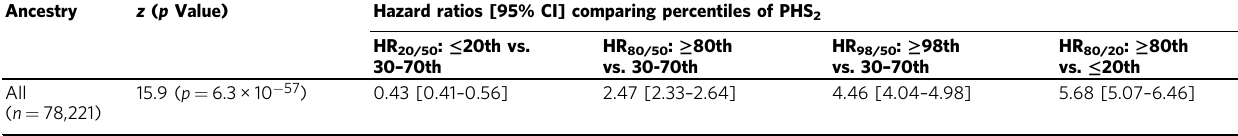
Table 3 Association of PHS with death from prostate cancer.